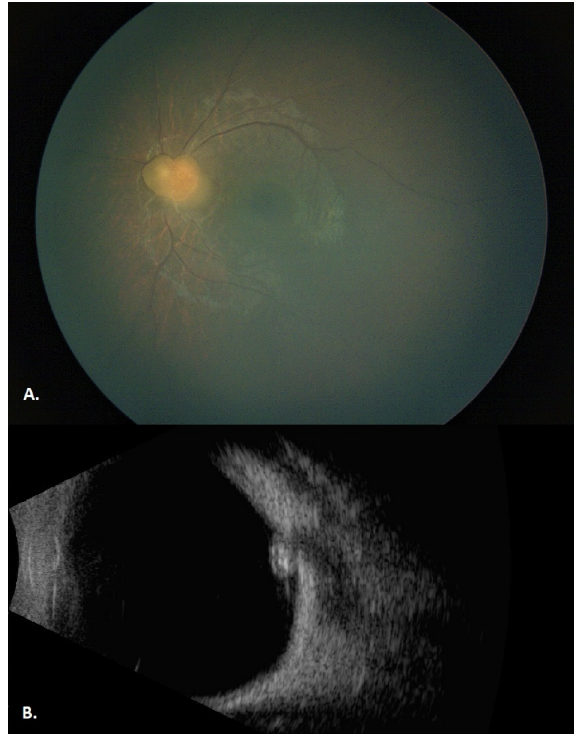
Figure 1: A) Fundus image of the left eye at initial examination shows a well-defined, opaque, minimally calcified, whitish-yellow lesion that is covering the optic disc. B) B-scan ultrasonography image of the left eye at initial examination shows high internal reflectivity, posterior shadowing, and intratumoral cystic